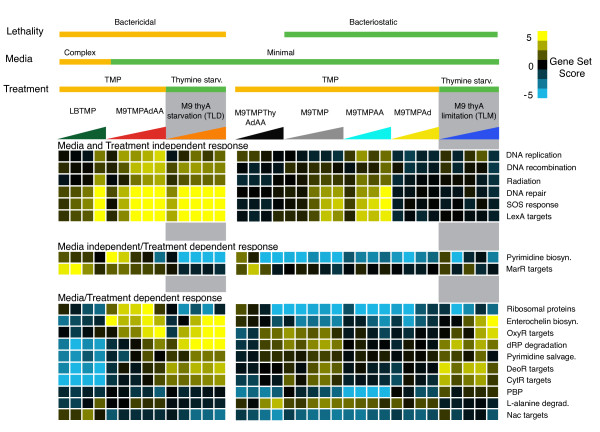
SOS response is uniquely associated with thymineless induced lethality across treatment regimens and growth conditions. Heatmap of gene set scores associated with TMP treatment and thymineless death (TLD)[37]. Blue and yellow color refers to down-regulation and up-regulation of gene sets respectively. Condition labels are as described in Table 1. dRP: deoxyribosephosphate; SS: supercoiling; PBP: periplasmic binding proteins.